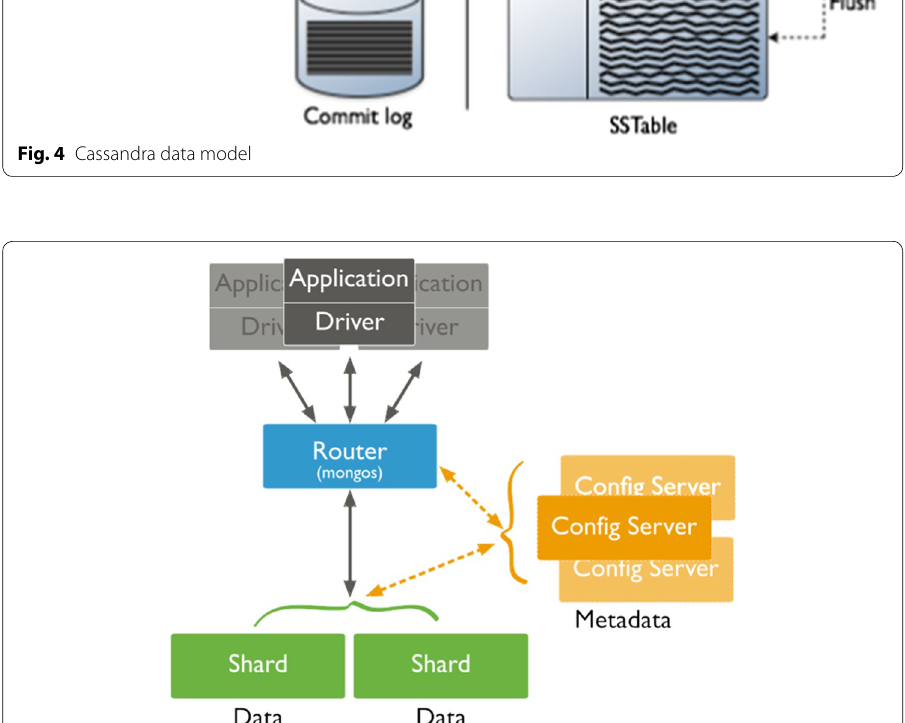
Fig. 5 MongoDB data